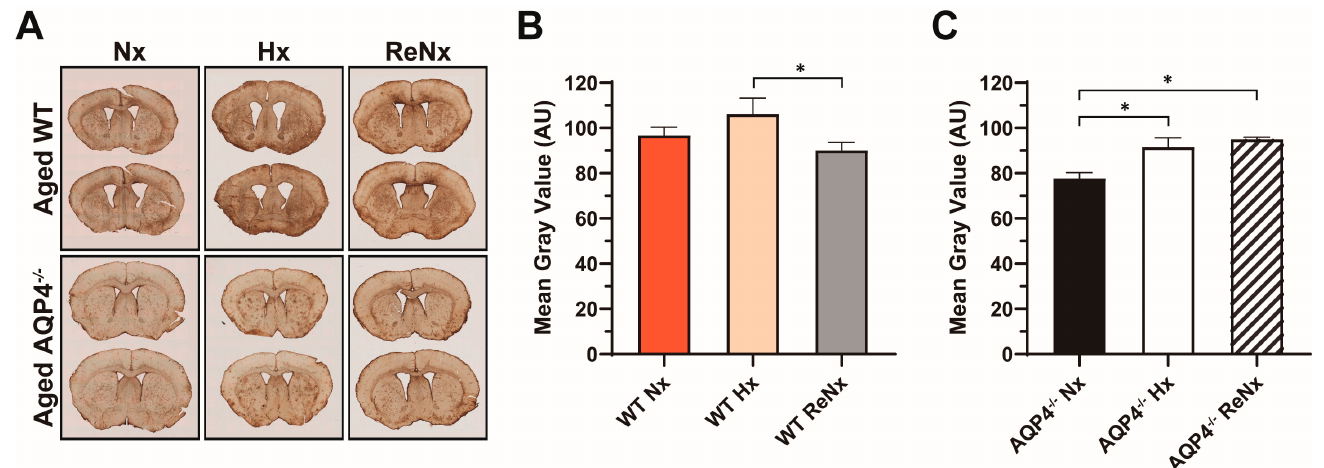
Figure 5. Astroglial response to hypoxia and re-normoxia of aged wt and AQP4 -/- mice. ( A ) Images, after GFAP immunohistochemistry, of coronal brain sections from aged wt and AQP4 -/- mice subjected to the experimental conditions indicated (Nx: normoxia; Hx: hypoxia; ReNx: re-normoxia). ( B ) Analysis of GFAP optical density of aged wt and AQP4 -/- mice in Nx. ( C ) Quantification of the astroglial response, by GFAP optical density measurements, to Hx and ReNx in aged wt and AQP4 -/- mice. Data are expressed as fold changes of GFAP labeling in either condition, Hx or ReNx, with respect to their own normoxic controls. Levels of GFAP in Nx for aged wt or AQP4 -/- mice were taken as 100% and are represented as dashed lines in each graph. Data are presented as mean ± SEM, and the number of animals tested for each experimental condition was n = 3, * p < 0.05.